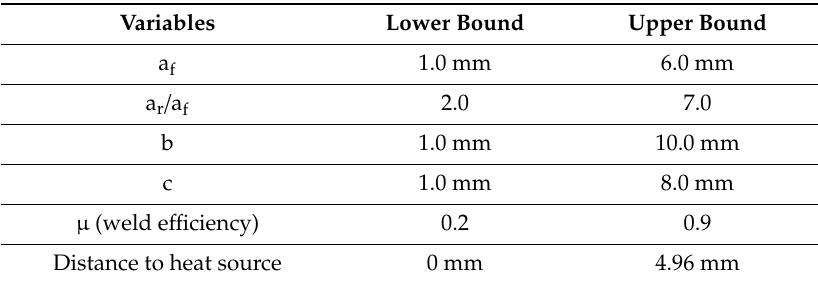
Table 5. Variables and range.